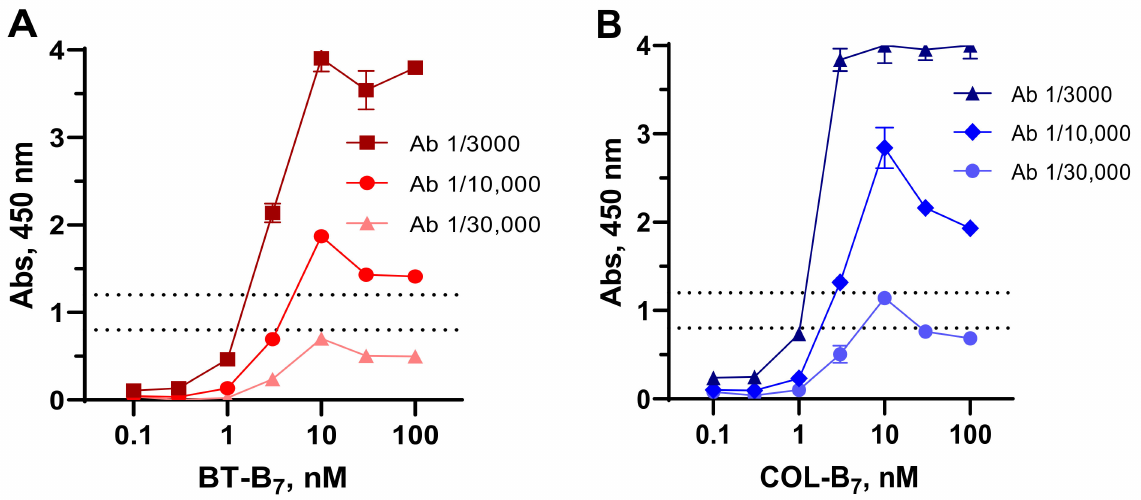
Figure 2. Checkboard titration of BT–B 7 ( A ) and COL–B 7 ( B ) on coated streptavidin detected by serially diluted anti-BT ( A ) and anti-PM ( B ) antibodies (Ab) in ELISA. The dashed lines indicate an absorbance range of 0.8–1.2.